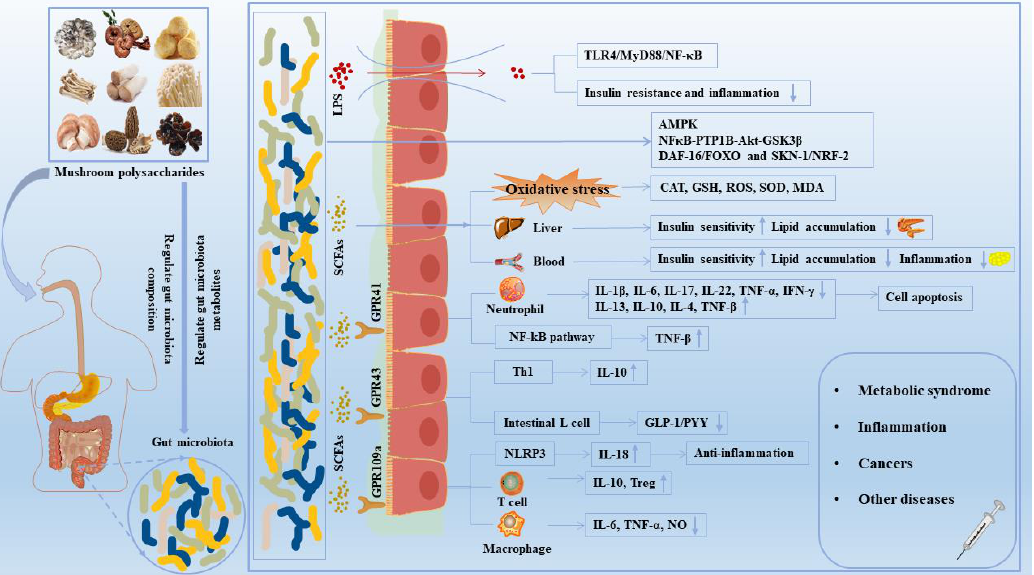
Figure 3. The effect of mushroom polysaccharides on human diseases by the regulation of gut microbiota. Mushroom polysaccharides could regulate the composition and relative abundance of gut microbiota and promote the production of SCFAs. SCFAs bond to receptors such as GPR41, GPR43 and GPR109A, activating downstream NF- κ B, MAPK and other signaling pathways, thereby improving the intestinal mucosal barrier and maintaining intestinal homeostasis. In addition, SCFAs exerted an anti-diabetic and anti-obesity role by alleviating oxidative stress damage and regulating liver and blood biochemical indexes. Notably, harmful gut microbiota induced inflammation and insulin resistance by stimulating LPS secretion and activating TLR4/MyD88/NF- κ B pathways. ↑ , increased; ↓ , decreased; CAT, catalase; GLP-1, glucagon-like peptide-1; GPR 109a, G protein- coupled receptor 109A; GPR 43, G protein-coupled receptor 43; GPR 41, G protein-coupled receptor 41; GSK3 β , glycogen synthase kinase 3 β ; GSH, glutathione; IFN- γ , interferon- γ ; IL, interleukin; LPS, lipopolysaccharide; MDA, malondialdehyde; MyD88, myeloid differentiation factor 88; NF- κ B, nuclear factor- κ B; NO, nitrogen monoxide; PYY, peptide YY; ROS, reactive oxygen species; SCFAs, short-chain fatty acids; SOD, superoxide dismutase; Th, helper T cell; TLR4, toll-like receptor 4; TNF- α , tumor necrosis factor- α